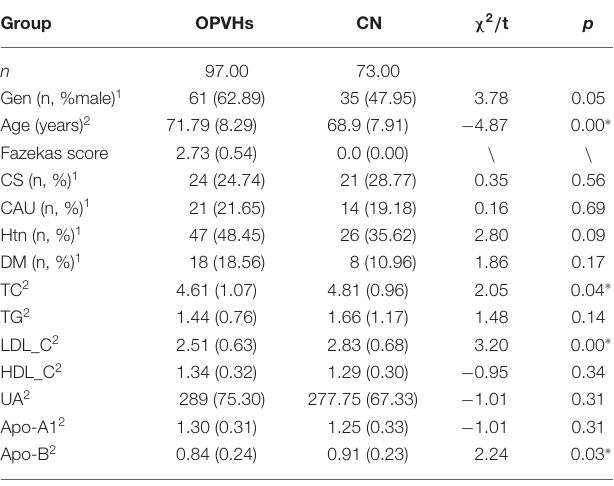
TABLE 2 | VBM results of the gray matter atrophy in OPVHs patients compared with CN. Brain area